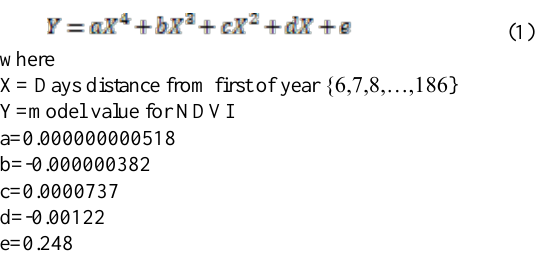
Figure 1. Time series of NDVI, NDI, IAVI, GNDVI By averaging the NDVI time-series, the sugarcane growth profile was modelled in the studied area (Figure 2). The curve fitting tool in MATLAB was used to parameterize the growth profile. The fourth-degree polynomial equation was selected because it had the best correlation to real data (R 2